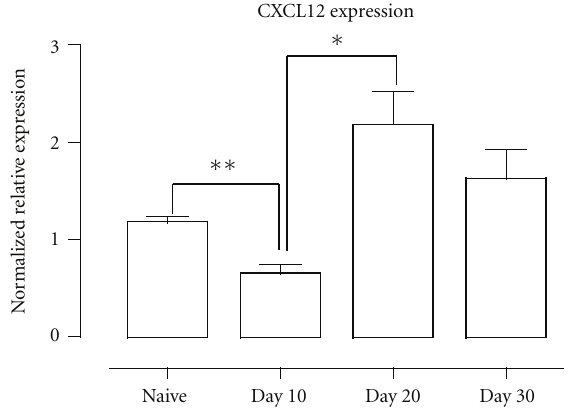
Figure 3: Bone marrow CXCL12 mRNA expression during Pc AS infection. BM was isolated and amplified using intron-spanning primers specific for CXCL12 via Quantitative PCR. Data were nor- malized to S12 expression and are presented as relative expression compared to uninfected controls. Data are represented as mean of 3 mice ± SEM and are representative of two separate experiments were performed. ( ∗ ) P < . 05, ( ∗∗ ) P < .